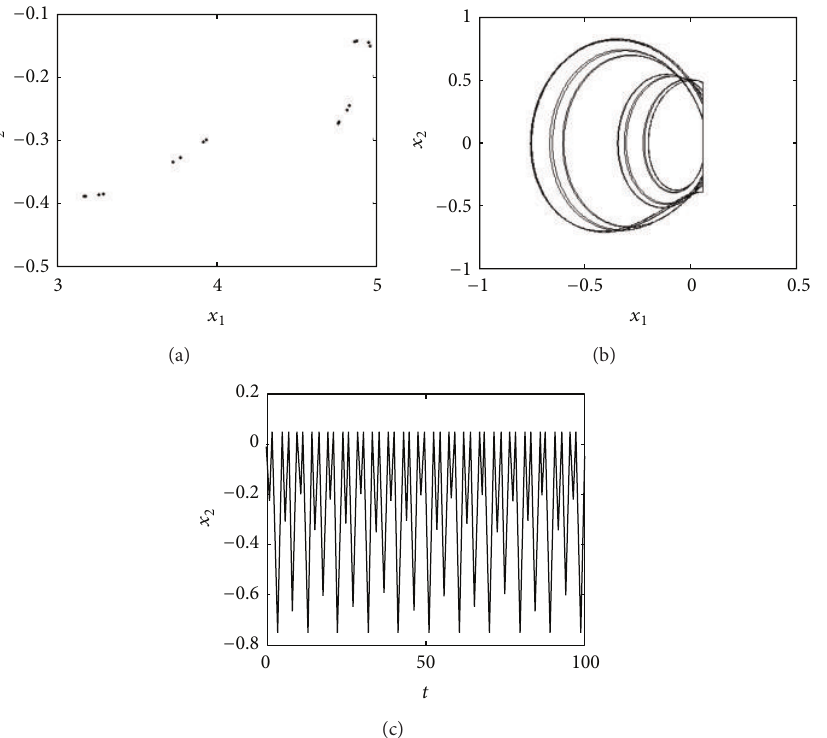
Figure 7: Poincar ´ e map, phase portrait, and time course diagram of the system with 𝜔 = 2.644